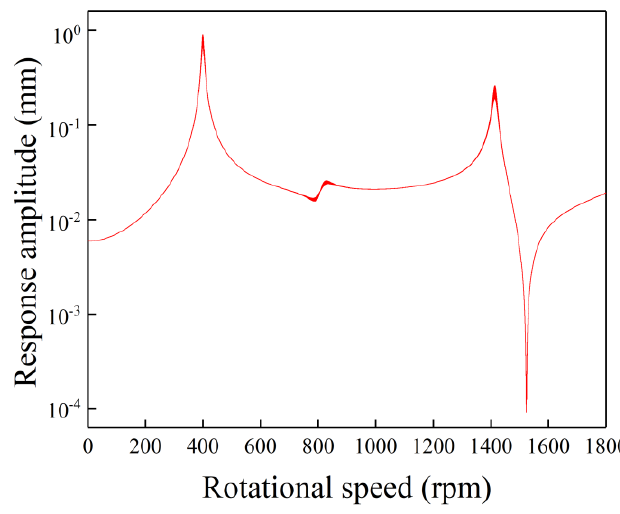
Figure 5. The bounds of uncertain gravity response versus rotational speed by CIM with a 15% deviation in the bearing’s damping.